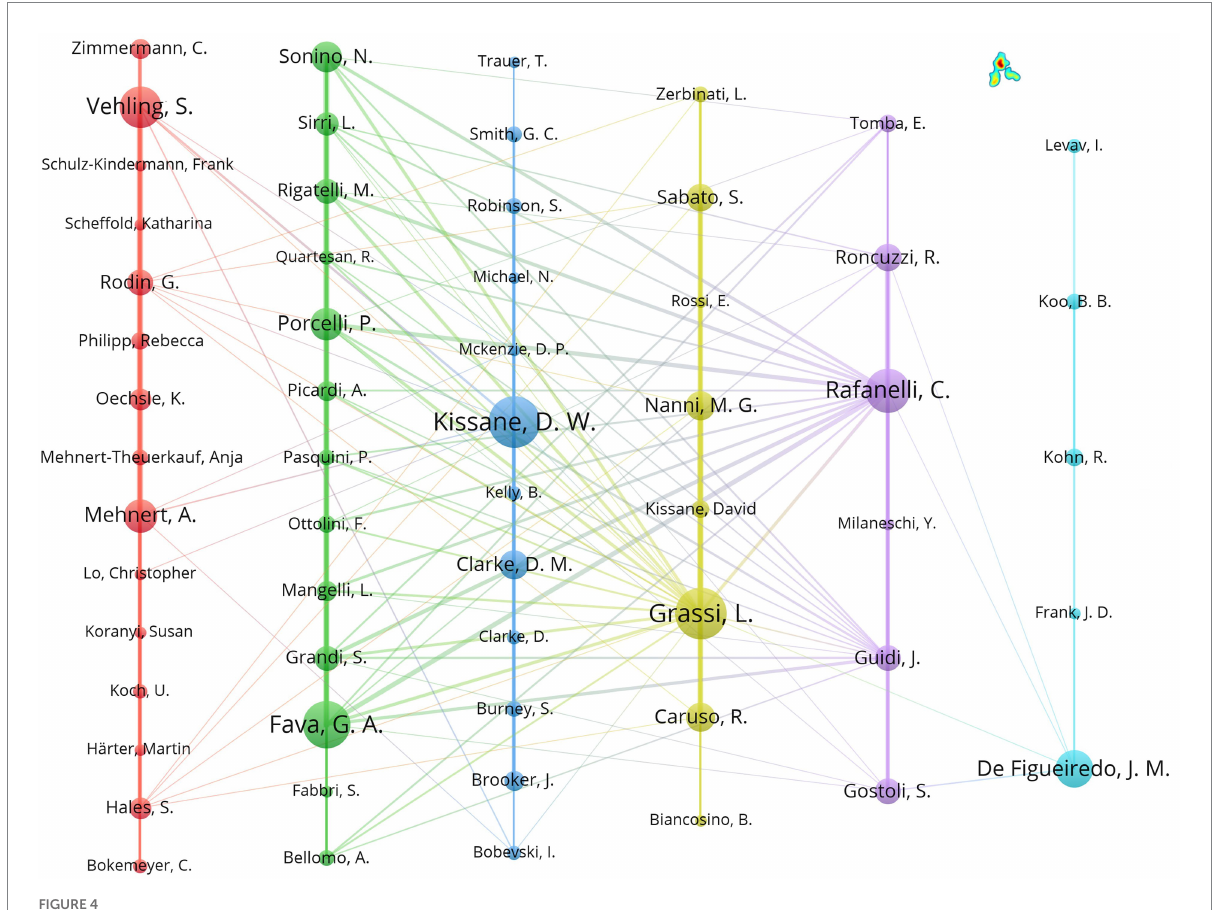
FIGURE 4 Author collaboration